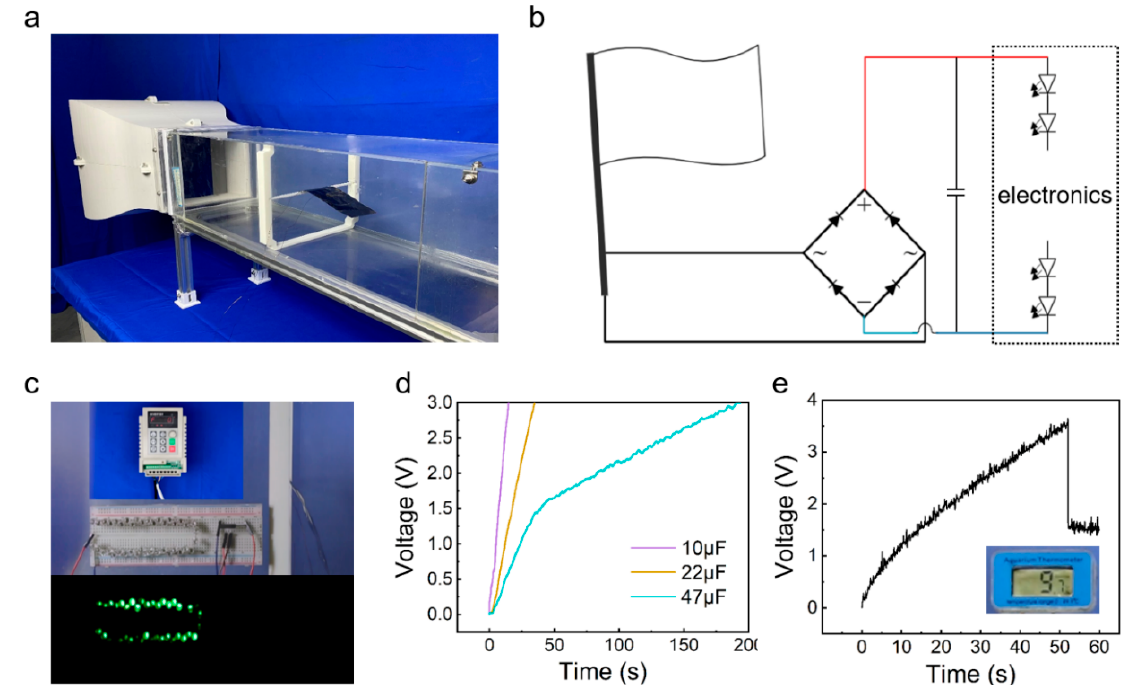
Figure 4. Demonstration of the HF-TENG as a sustainable power source. ( a ) Schematic of the experimental apparatus. ( b ) Proposed circuit diagram for continuously powering the electronics with the HF-TENG as a sustainable power source. ( c ) The charging curves of three different commercial capacitors (10 µ F, 22 µ F, and 47 µ F) by the HF-TENG. ( d ) Demonstration of the HF-TENG to power a thermometer. ( e ) Demonstration of the HF-TENG to light up the LEDs.